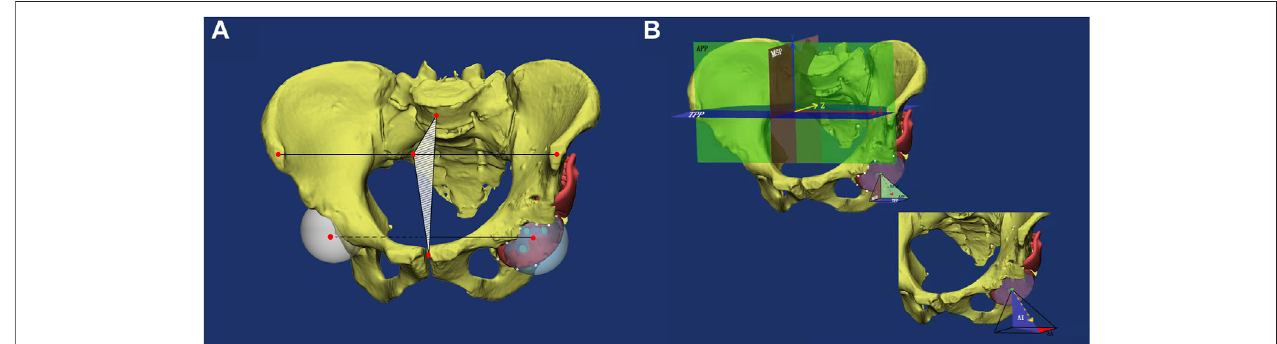
FIGURE 3 | A diagram to illustrate choice of reference fi lm, rotation center and measurement of anteversion and abduction angle. (A) . Midsagittal plane and reconstructionofrotationcenter.Whitepointswerechosenaroundcupsurfaceasmarkerstohelpreconstructrotationcenter(tworedpointsinacetabulum).Midsagittal plane was determined by midpoint of bilateral anterosuperior iliac spines, center of pubic symphysis and the midpoint of fi fth lumbar vertebra. (B) . Three reference fi lms and the measurement of anteversion and abduction angle of cup. APP: anterior pelvic plane. MSP: midsagittal plane. TPP: transverse pelvic plane. AA: anatomic anteversion. AI: anatomic